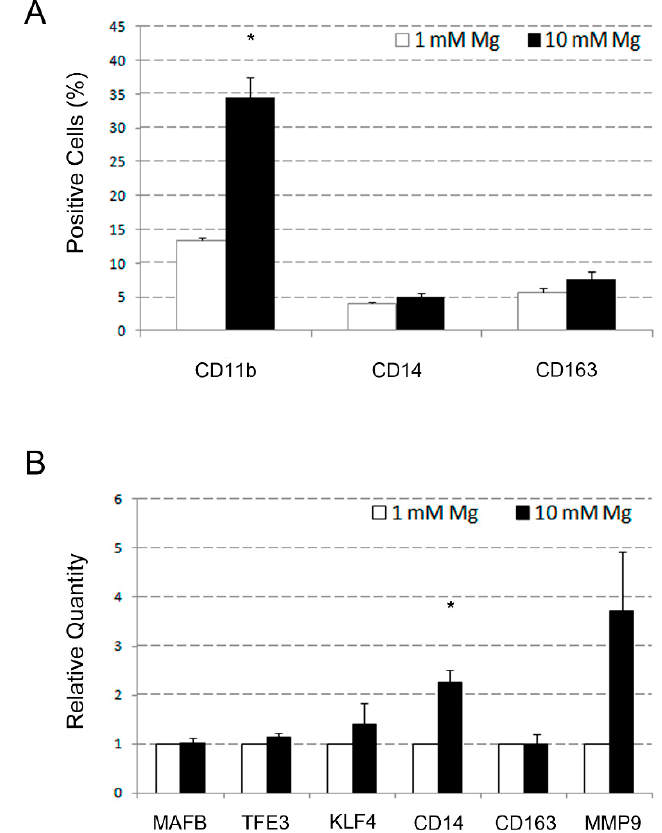
Figure 4. Effects of treatment with supra-physiological Mg concentrations on U937 cell-derived macrophages. U937 cells were differentiated to macrophages by exposure to PMA for two days, and simultaneously exposed to 1 and 10 mM Mg. Cell samples were then analyzed and the results presented as detailed in the legend of Figure 3. ( A ) Results from cell samples subjected to flow cytometry. ( B ) Results from cell samples subjected to QRT-PCR analysis.